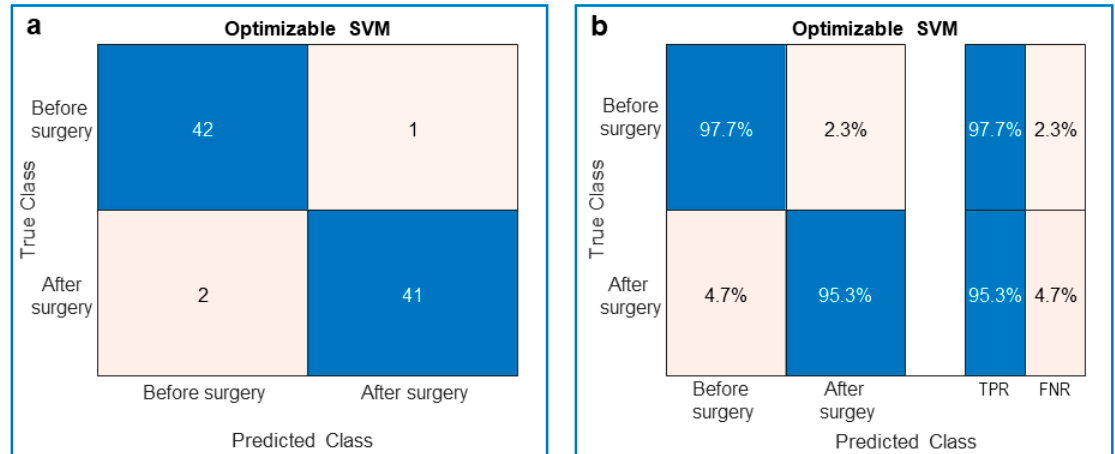
Figure 3. Performance of the trained optimizable support vector machine (SVM) classifier. ( a ) Confusion matrix showing the true and predicted classes of the ToF patients’ videos. The blue diagonal is related to the number of videos that were truly recognized (Predicted Class = True Class), whereas the pink antidiagonal is related to the number of videos that were falsely recognized (Predicted Class ≠ True Class). ( b ) Same as ( a ) the True Positive Rate (TPR) in blue and the False Negative Rate (FNR) in pink.